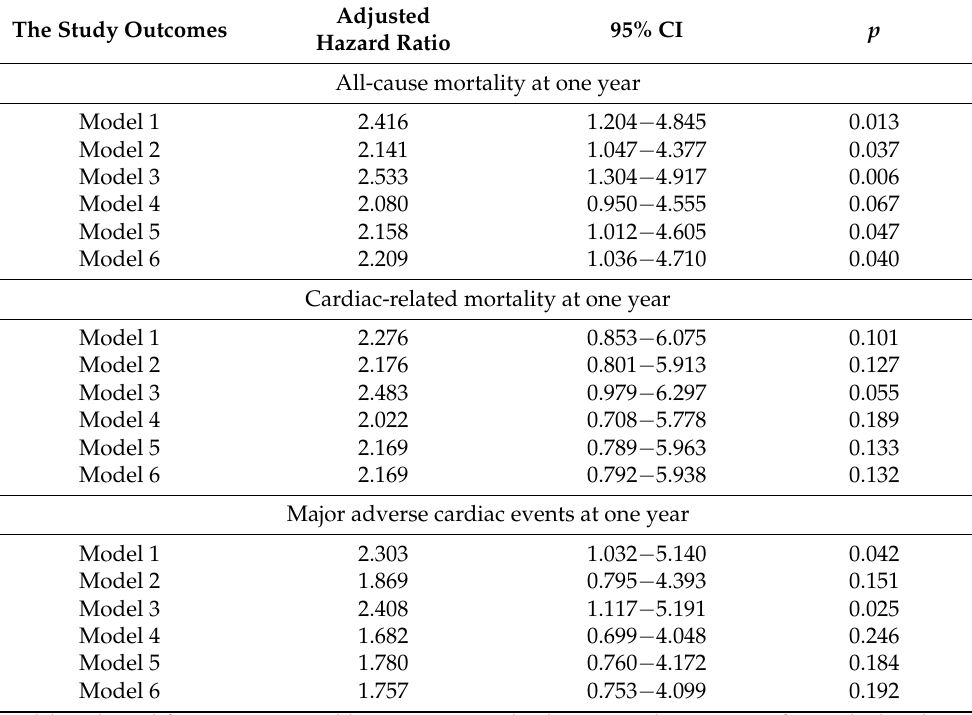
Table 3. The association between atrial fibrillation and the study outcomes in the sensitivity analyses. Adjusted The Study Outcomes Hazard